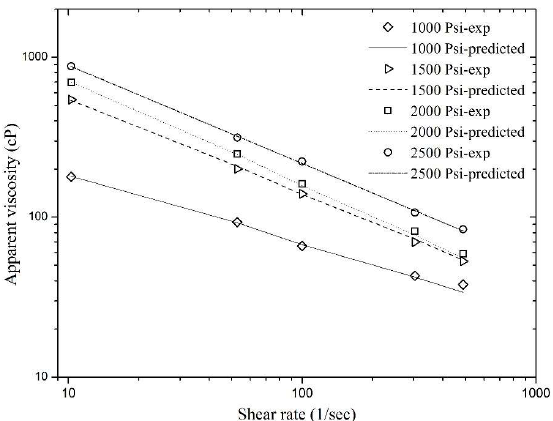
Figure 8. Match of the predicted viscosity values of sCO 2 foam using Equation (10) with the experimental data. Table 3. Parametric estimates of the sCO 2 foam viscosity model (Equation (10)). Parameter Estimate